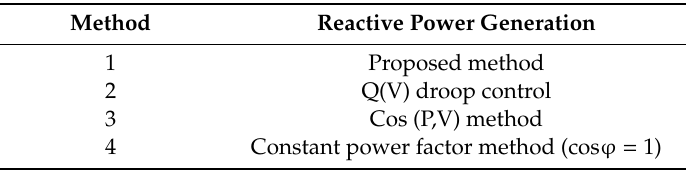
Table 5. Comparison of reactive power generation methods.